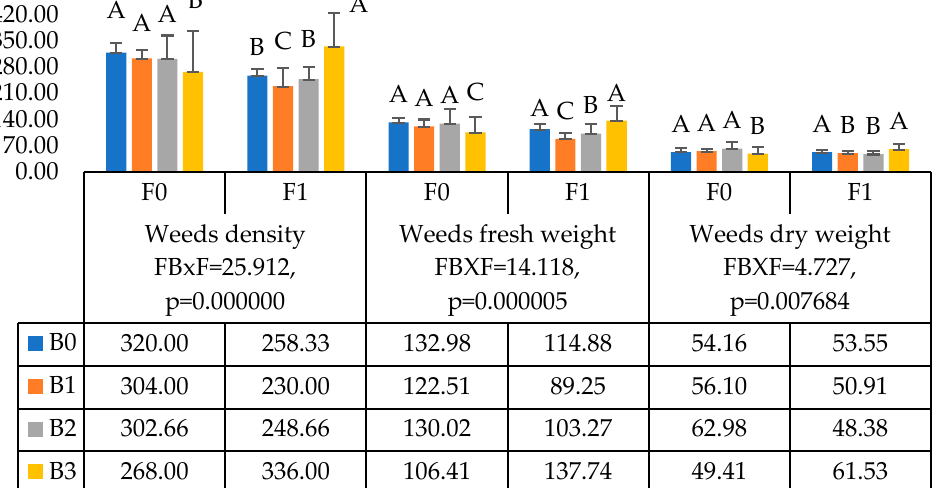
Table 8. Biochar and fertilization effects on winter wheat yield (t ha − 1 ) at the experimental sites Gat and